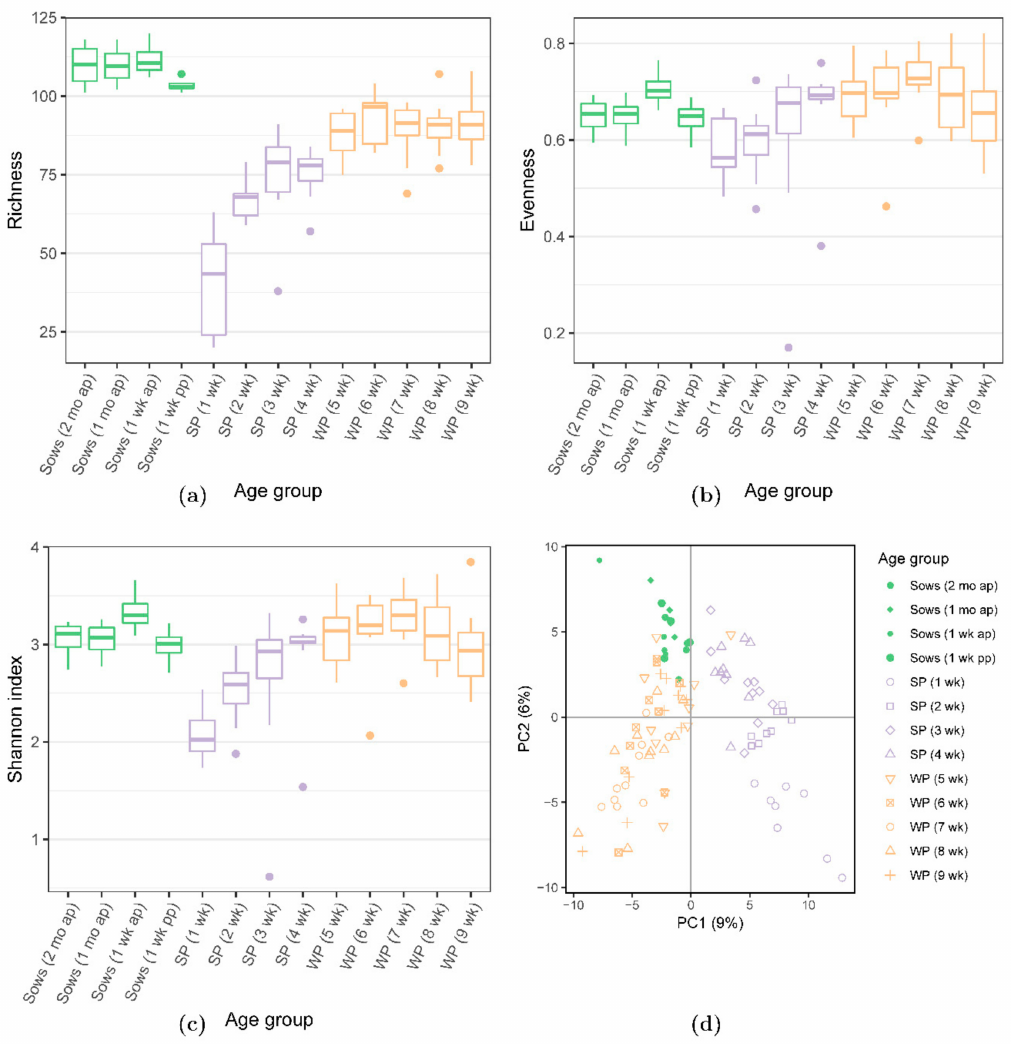
Figure 2. Diversity shown as ( a ) richness, ( b ) evenness, and ( c ) Shannon indices, and ( d ) a principal component analysis performed using the relative abundance of faecal microbial taxa in sows (green box plots), suckling (violet box plots) and weaned piglets (orange box plots) over time, as analysed by the 16S rDNA sequencing. Dots in figures ( a – c ) indicate outliers. ap: antepartum; pp: